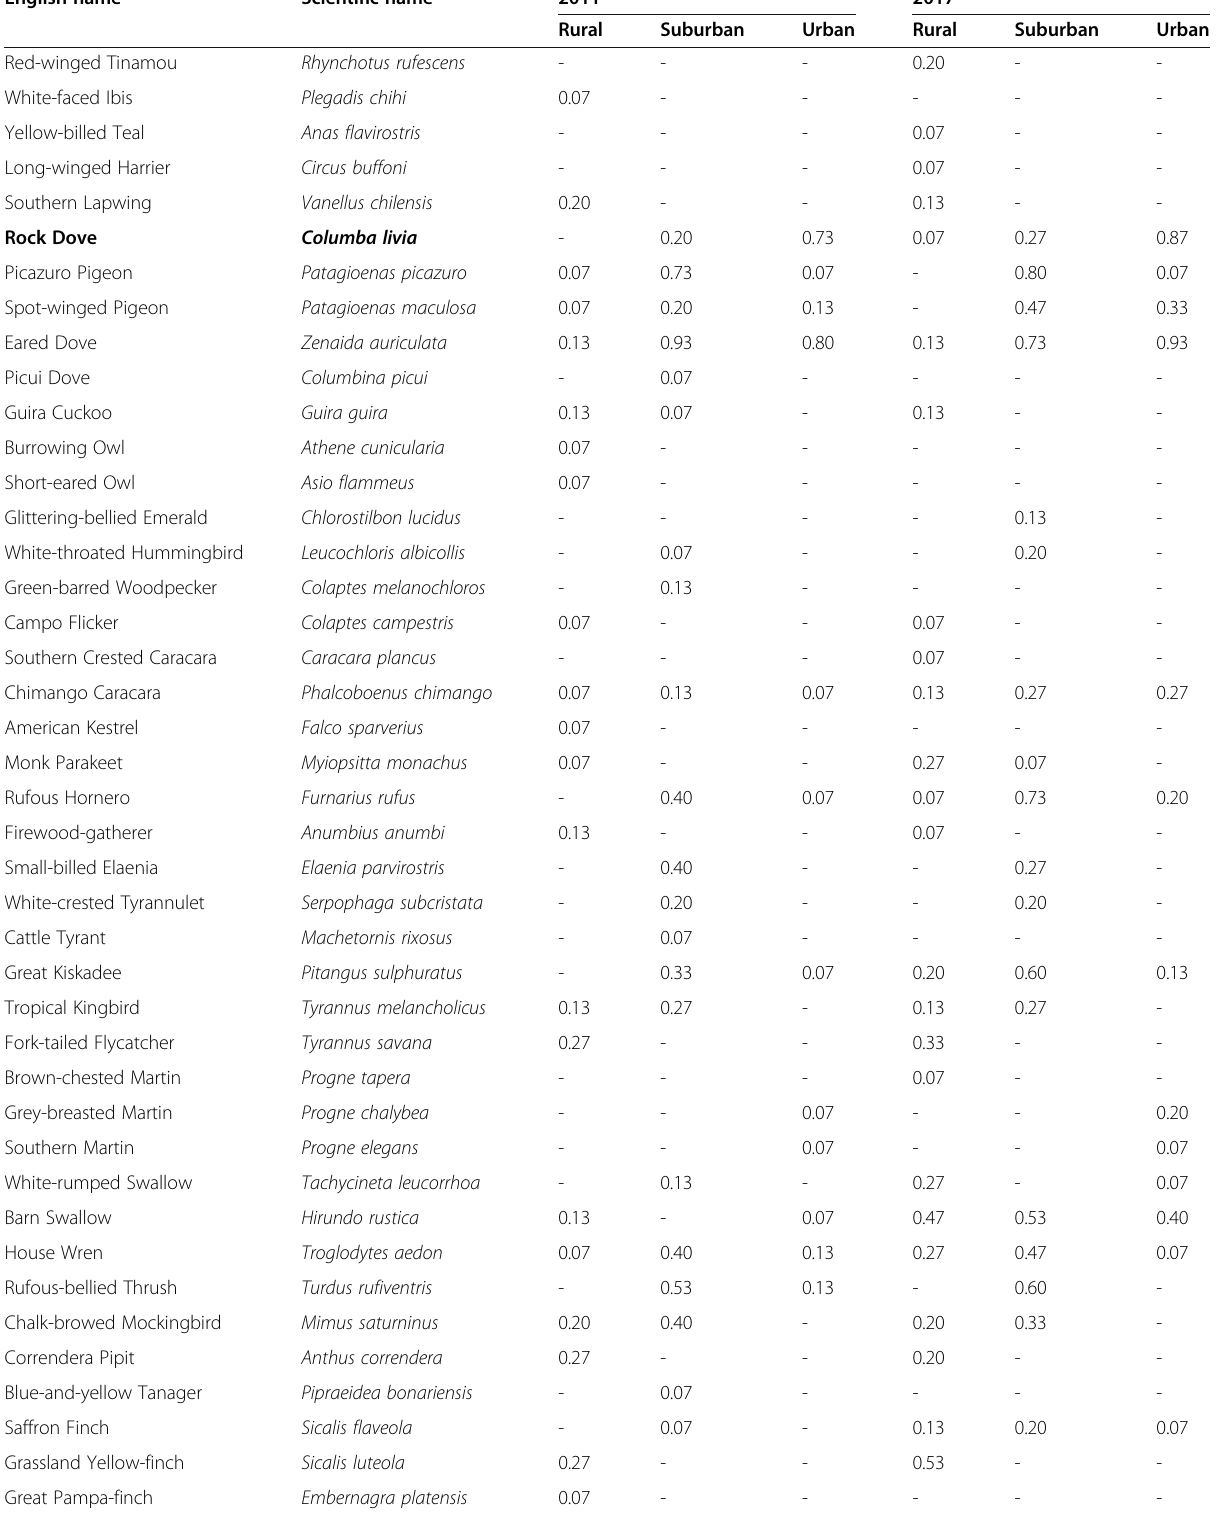
Table 1 Species frequencies (proportion of transects occupied) along the three rural-urban gradients during 2011 and 2017 in central